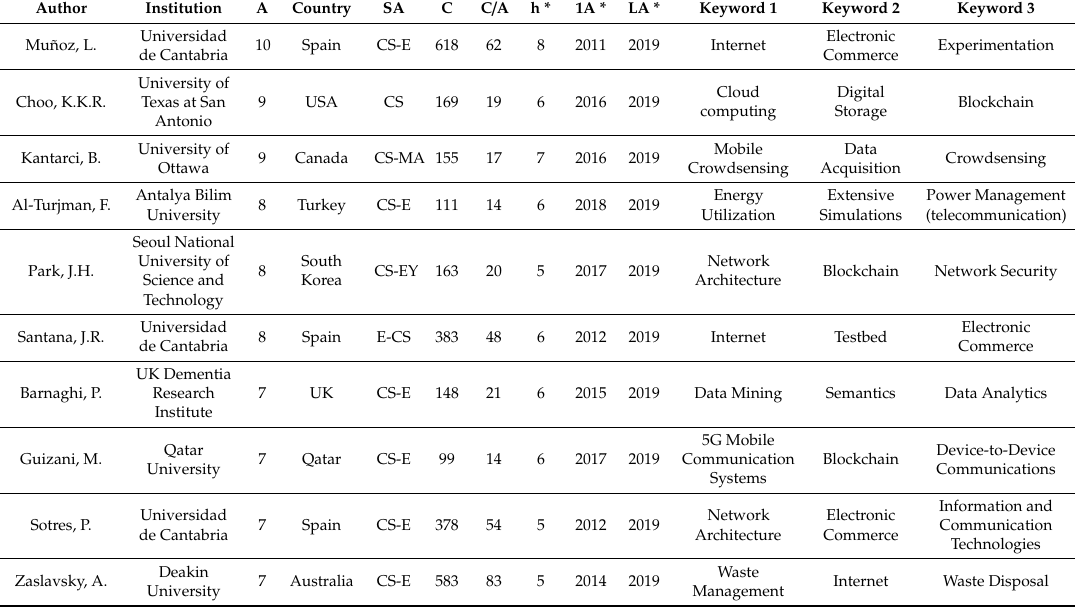
Table 11. Top 10 authors and main keywords